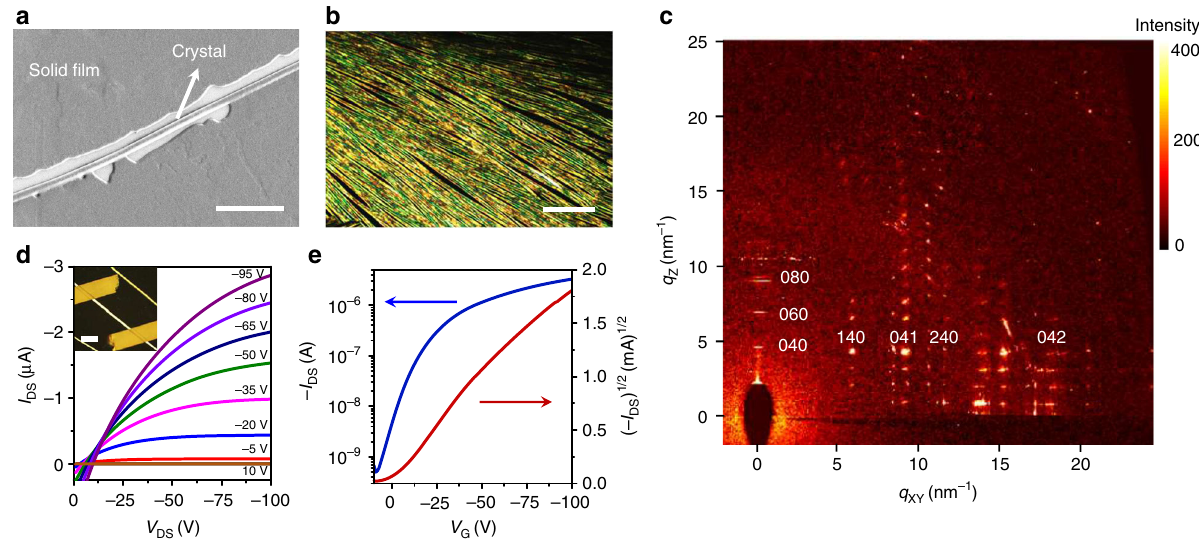
Fig. 5 Formation of single-crystal microwires from solid fi lms. a SEM image showing that an ultralong organic microwire crystallises from solid fi lms with the prolonged growth time. Scale bar: 5 µ m. b Optical image showing a high-density oriented microwire array. Scale bar: 400 µ m. c Synchrotron radiation grazing incident X-ray diffraction of single-crystal fi lm/microwire hybrids. More details about unit cell parameters can be found in the Supplementary Table 5. d Output characteristics of a microwire single-crystal OFET. Inset shows the polarised optical image of the device. L = 30 μ m and W = 1.5 μ m. Gate voltage ( V GS ) ranged from 10 to − 95 V in − 15 V steps. Scale bar: 10 μ m. e Transfer characteristics with the source-drain voltage ( V DS ) of − 50